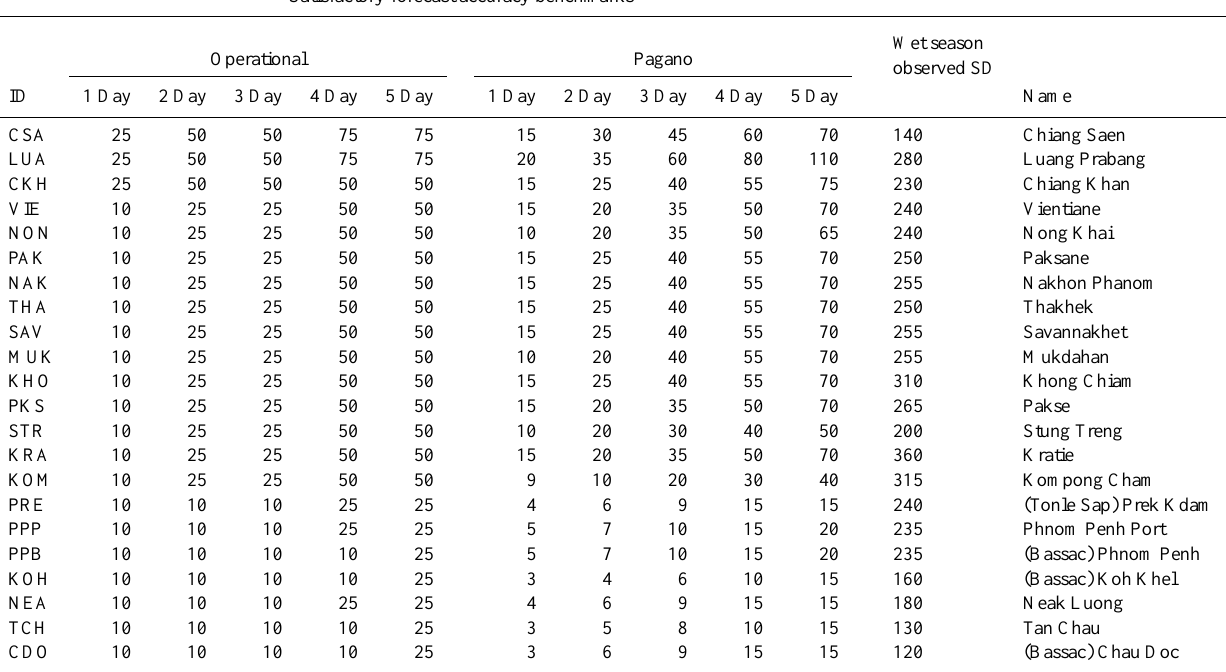
Table 2. Performance benchmarks currently used operationally (left, from Smith, 2009) and proposed by this study (right). The table is ordered from upstream to downstream. The right-most numbers are the period of record standard deviation of wet season observations. Units are in